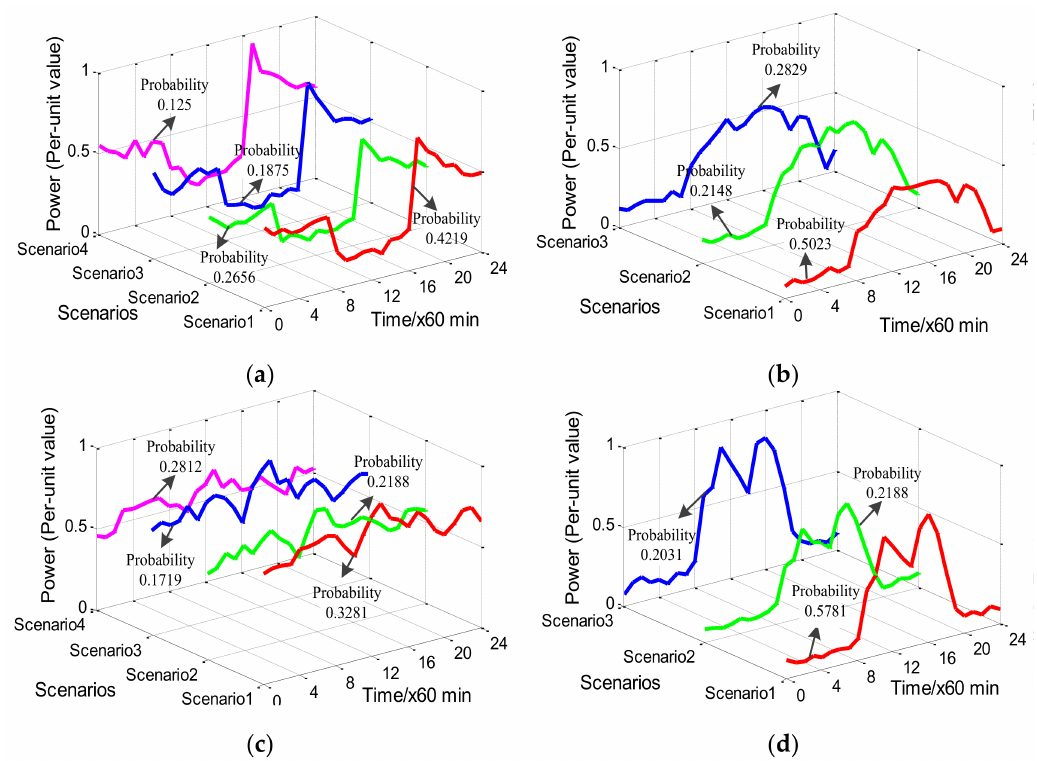
Figure 8. The timing scenarios of the winter thermal load on weekdays for typical functional